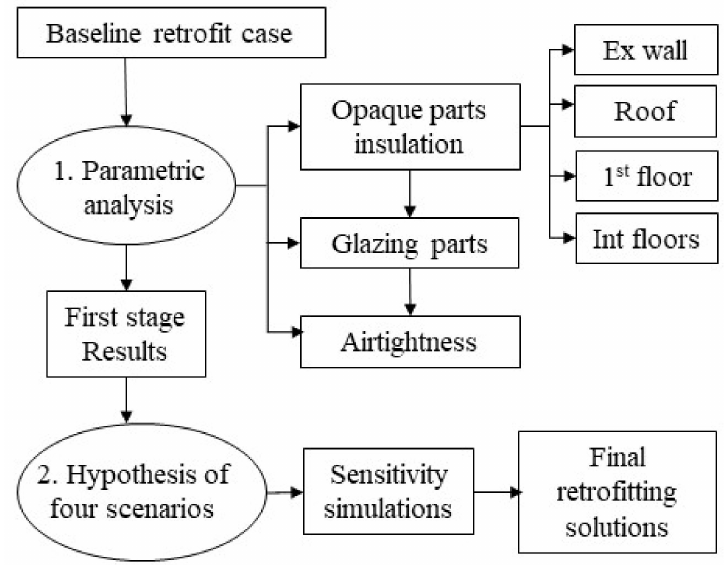
Figure 4. Workflow of the